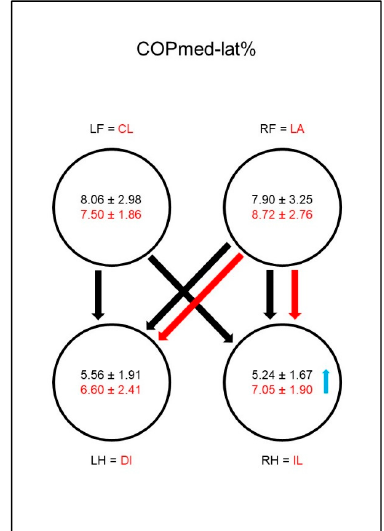
Figure 15. Medio–lateral displacement of the center of pressure as a percentage of maximum width of paw contact area (COPmed-lat%) in study group 2 and control group. For detailed explanation and abbreviations refer to Figure 2.